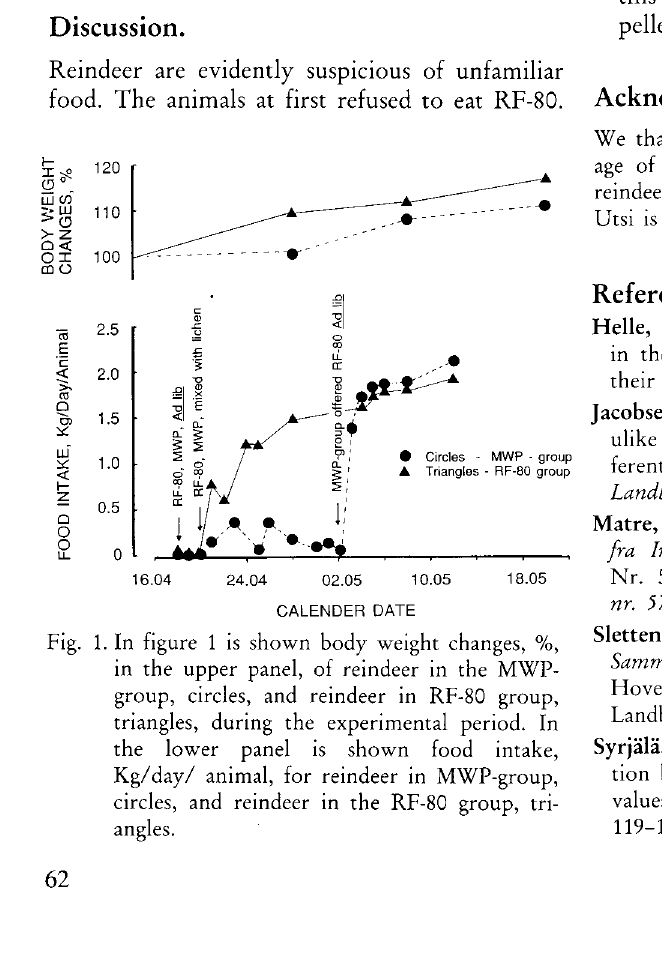
Fig. 1. In figure 1 is shown body weight changes, %, in the upper panel, of reindeer in the MWP- group, circles, and reindeer in RF-80 group, triangles, during the experimental period. In the lower panel is shown food intake, Kg/day/ animal, for reindeer in MWP-group, circles, and reindeer in the RF-80 group, tri